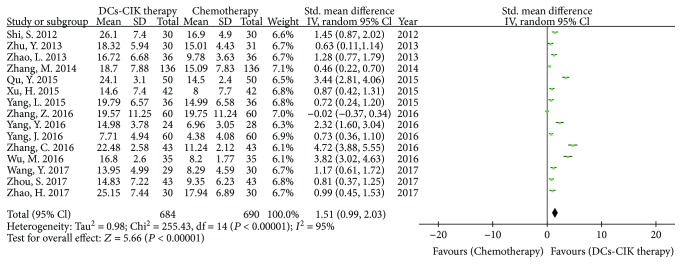
The analysis of NK cells between the two groups.